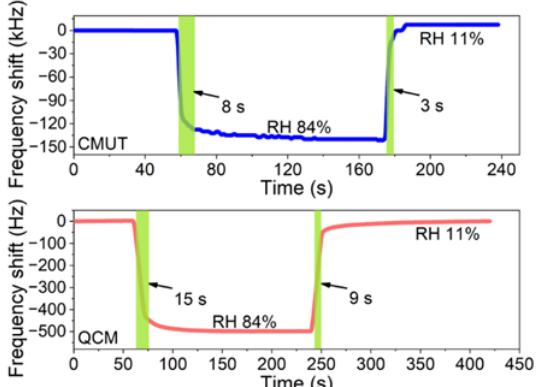
Figure 8. Dynamic responses of the CMUT and QCM sensors as the RH level alternates between 11% and 84%.